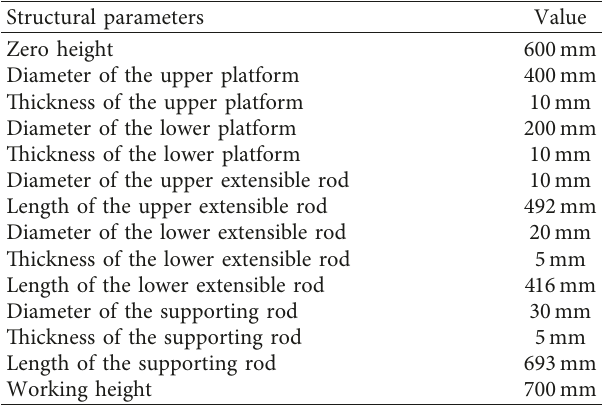
Table 3: Structural parameters of the TER pointing